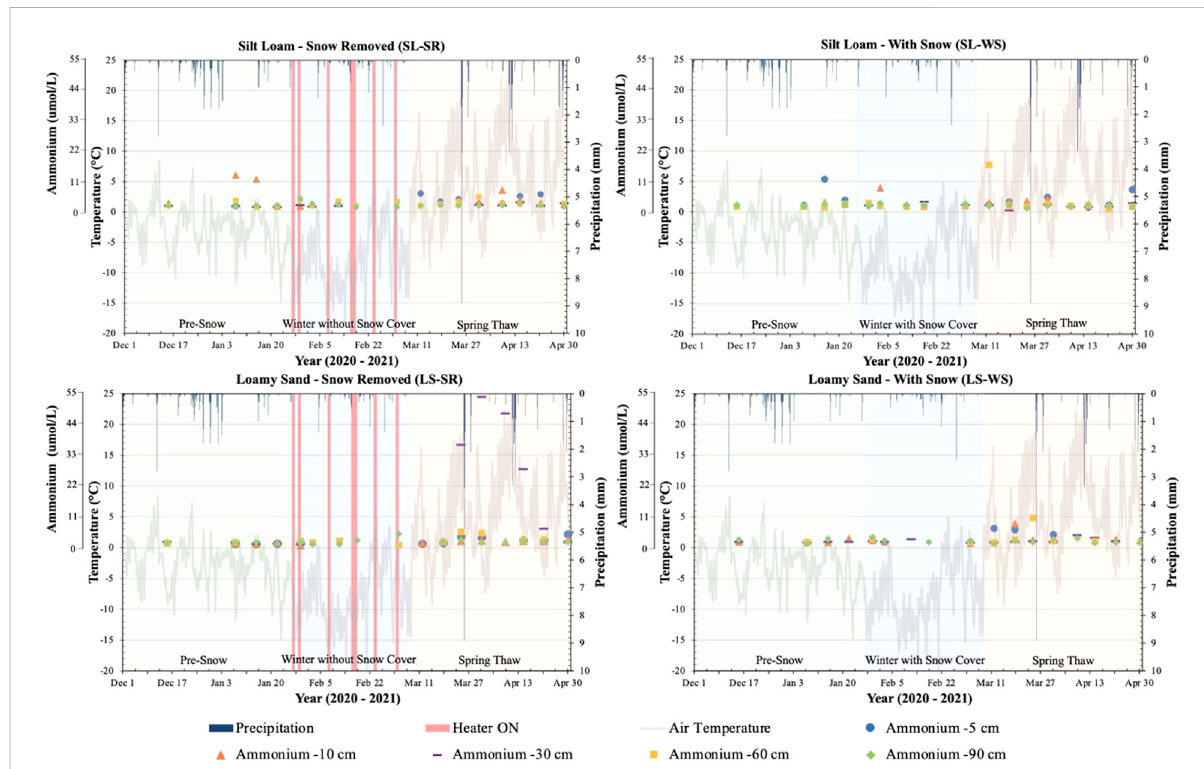
FIGURE 3 Porewater ammonium (NH 4 + ) concentration (tertiary y -axis) measured at -5, -10, -30, -60, and -90 cm depths in four lysimeters between 1 December 2020 and 30 April 2021. NH 4 + concentration is plotted with air temperature (primary y -axis) and precipitation (secondary y -axis) recorded from the Environment Canada Elora Weather Station. The graphs for SL-SR and LS-SR also show when the heaters were turned on and off duringthewintertomeltsnowonthelysimetersurface(redbarsonwinterwithoutsnowcoverphase).Thegraphsaredividedintothreephases, pre-snow, winter with/without snow, and spring-thaw, to determine the patterns of change during each of the experimental